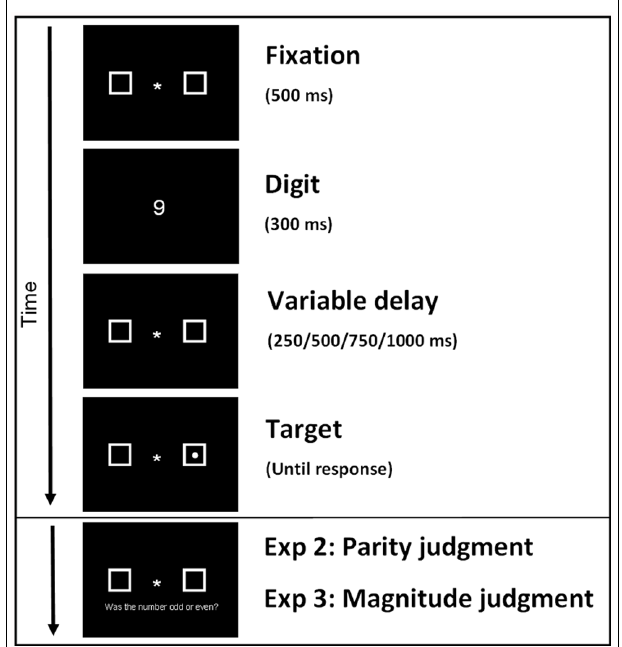
FIGURE 1 |The trial sequence started with a 500 ms fixation cross, followed by a 300 ms digit (1, 2, 8, 9) display, and a variable delay of 250, 500, 750, or 1000 ms. Then a target was presented randomly in one of the two placeholders on 80% of all trials. Participants had to respond as fast as possible by pressing the spacebar when they detected the target. In Experiment 2 and 3 participants decided after target detection whether the previously seen digit was odd or even (Experiment 2 and Replication Experiment 2) or whether the digit was higher or lower than 5 (Experiment 3 and Replication Experiment